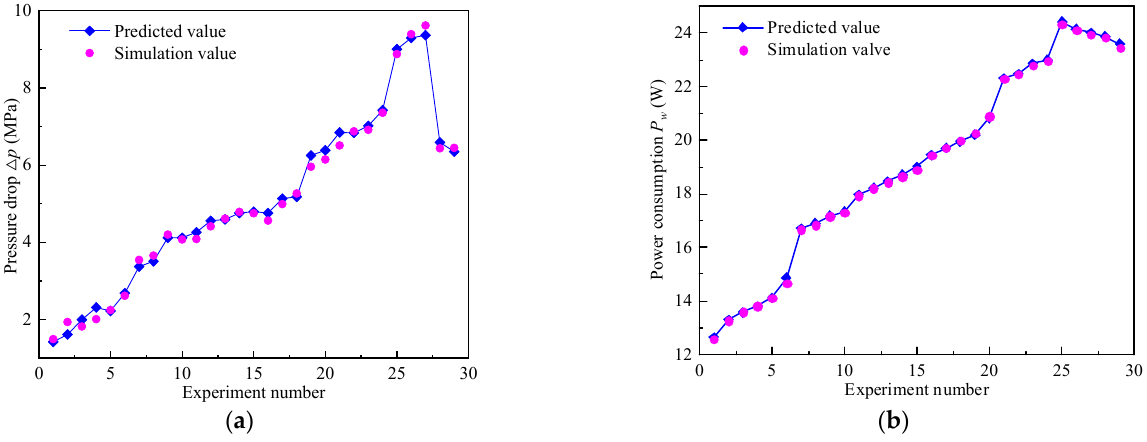
Figure 8. Comparison between predicted value and simulation value: ( a ) pressure drop Δ p , ( b ) power consumption P w.